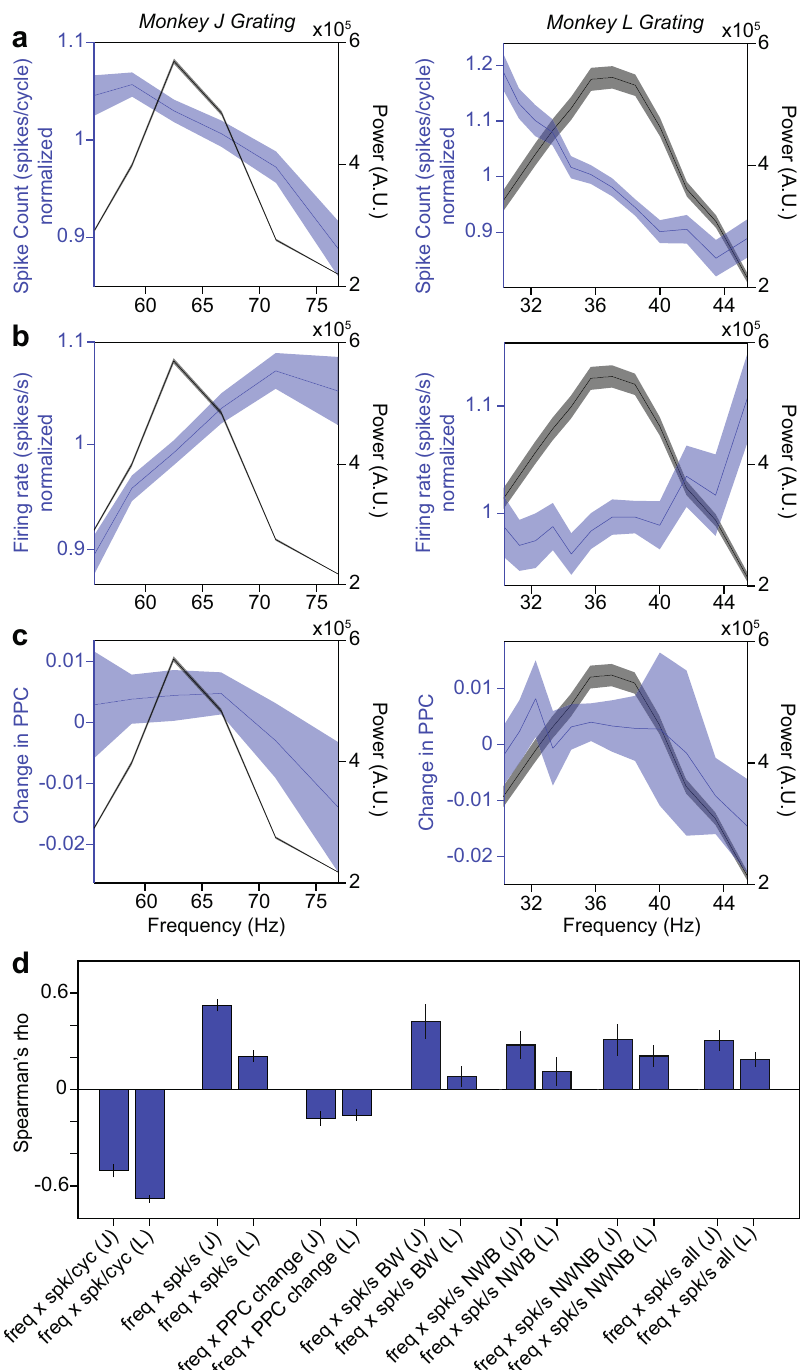
Fig. 6 The relationship between gamma-cycle duration and spiking. a The blue curve depicts the average normalized multi-unit (MU) spike count in detected gamma cycles of different durations, expressed on the x-axis as frequencies, for monkey J (left) and monkey L (right). The black curve depicts raw power in the gamma range of the respective monkeys. Error regions show ±2 SEM across units ( n = 156 and 127 independent MU channels examined over 35 and 40 independent sessions in monkey J and L, respectively). b Same as a , but using the normalized MU fi ring rate. c Same as a , but showing the normalized change in spike-LFP PPC. d Correlation between the gamma-cycle duration, expressed as frequency, and several spiking metrics, separately for the two monkeys (J and L). Vertical lines depict ±2 SEM across units (no signi fi cant difference between cell-types, Kruskall – Wallis test, p = 0.78. SU: n = 23, 17, 16 independent SUs for NWB, NWNB, BW in monkey J, from 35 independent sessions; n = 11, 11, 13 NWB, NWNB, and BW in monkey L across 40 independent sessions, respectively. MU: same n ’ s as in Fig. 6a). Source data are provided in the Source Data fi